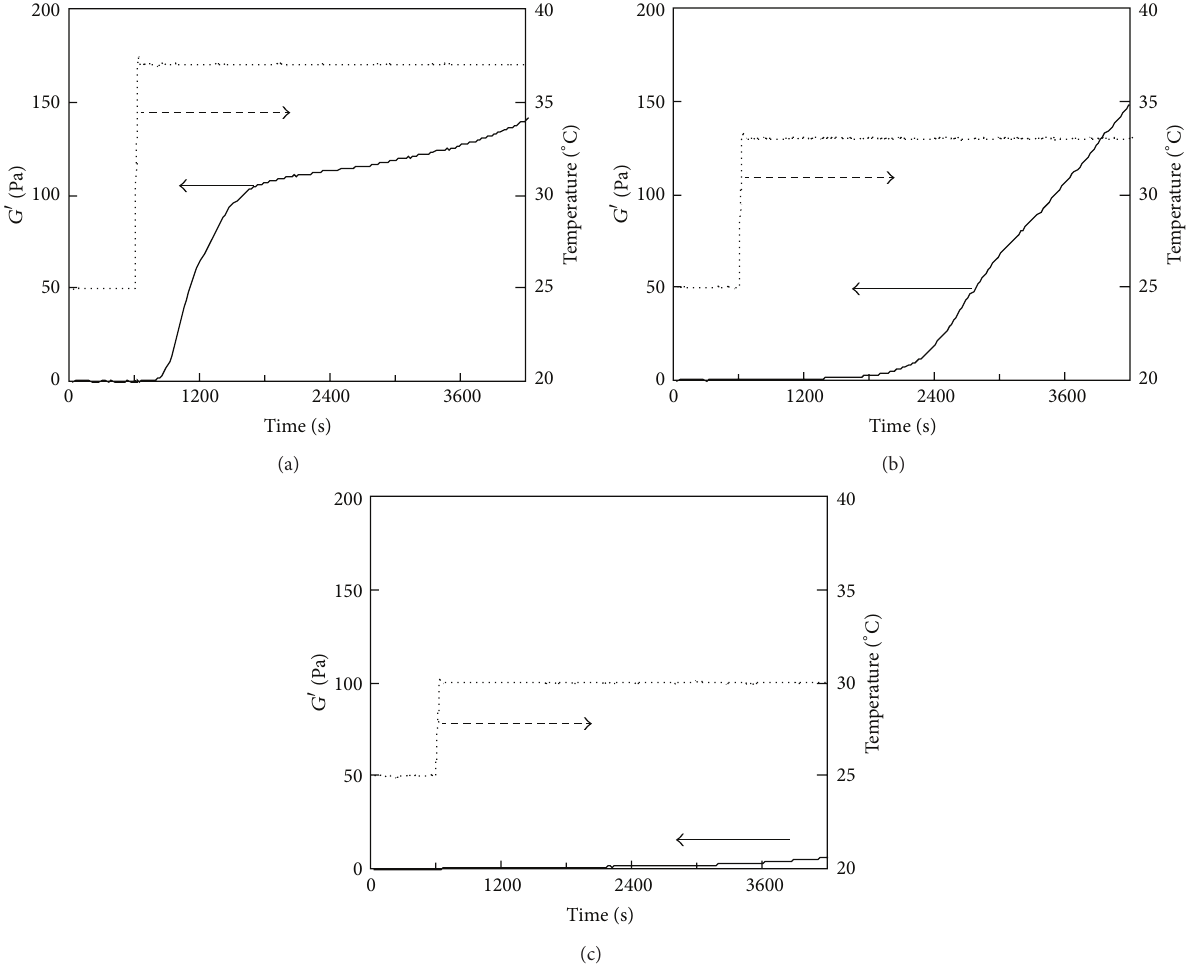
Figure 10: Storage modulus ( G 󸀠 ) of the 0.5% PSC solution containing no genipin with increase in temperature. The temperature was maintained at 25 ∘ C for 600s and then increased to (a) 37, (b) 33, or (c) 30 ∘